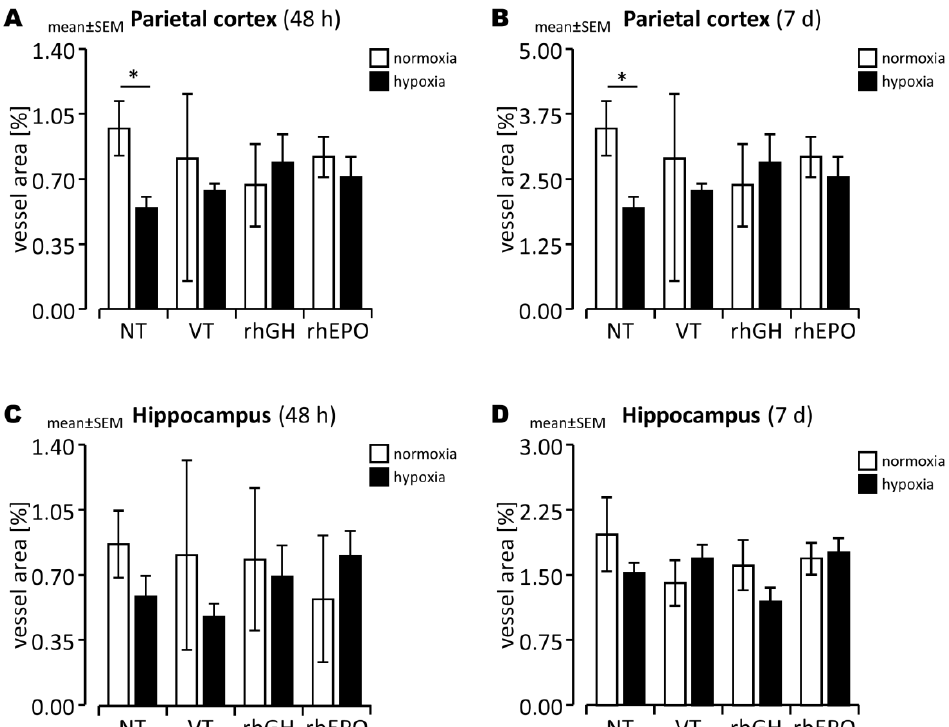
Figure 2. Vascular development in normoxic and hypoxic developing mouse brains with and without rhGH and rhEPO treatment. The vessel area in the parietal cortex ( A , B ) and hippocampus ( C , D ) was quantified by Pecam-1 IHC after a regeneration period of 48 h ( A , C ) and 7 d ( B , D ). Data are presented as mean ± SEM. *, p < 0.05.